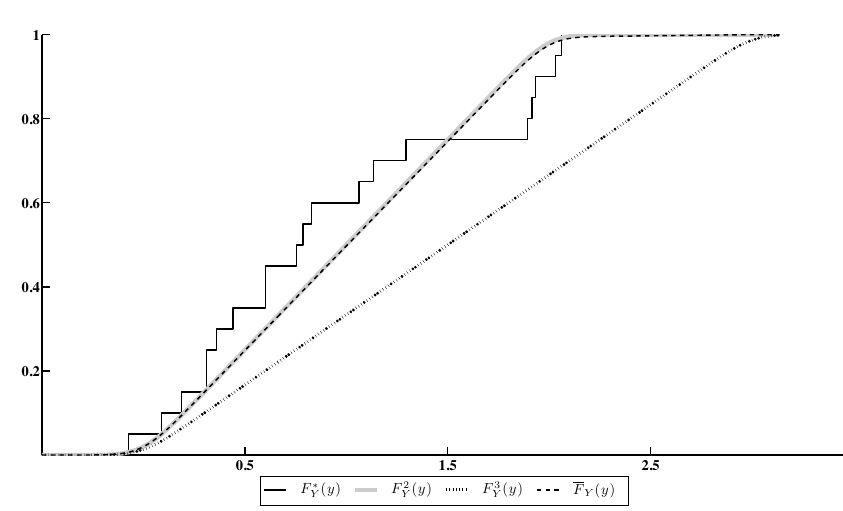
a ( r ) under the (cid:98)